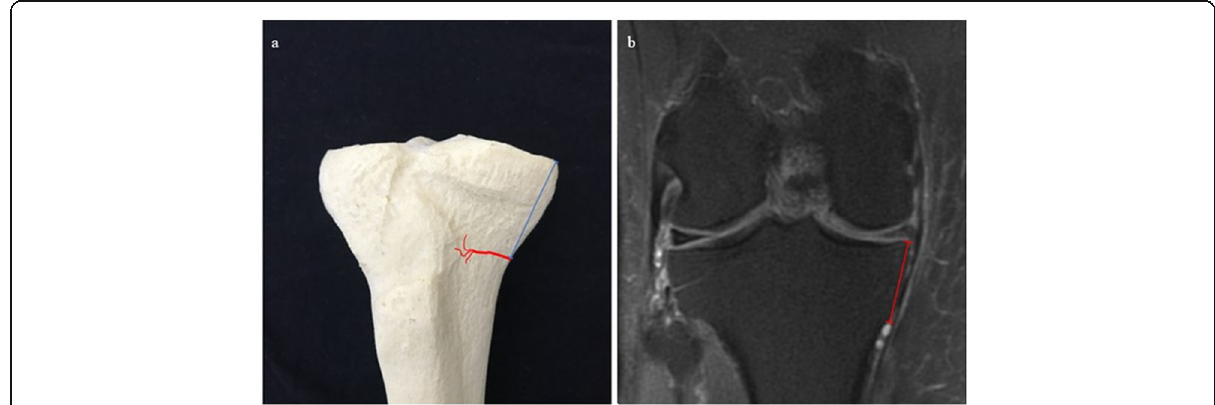
Fig. 4: a IMGA – MTP Cor (blue) drawn on a 3D model. IMGA course in red. b . IMGA-MTP Cor on T2w with fat suppression coronal sequence